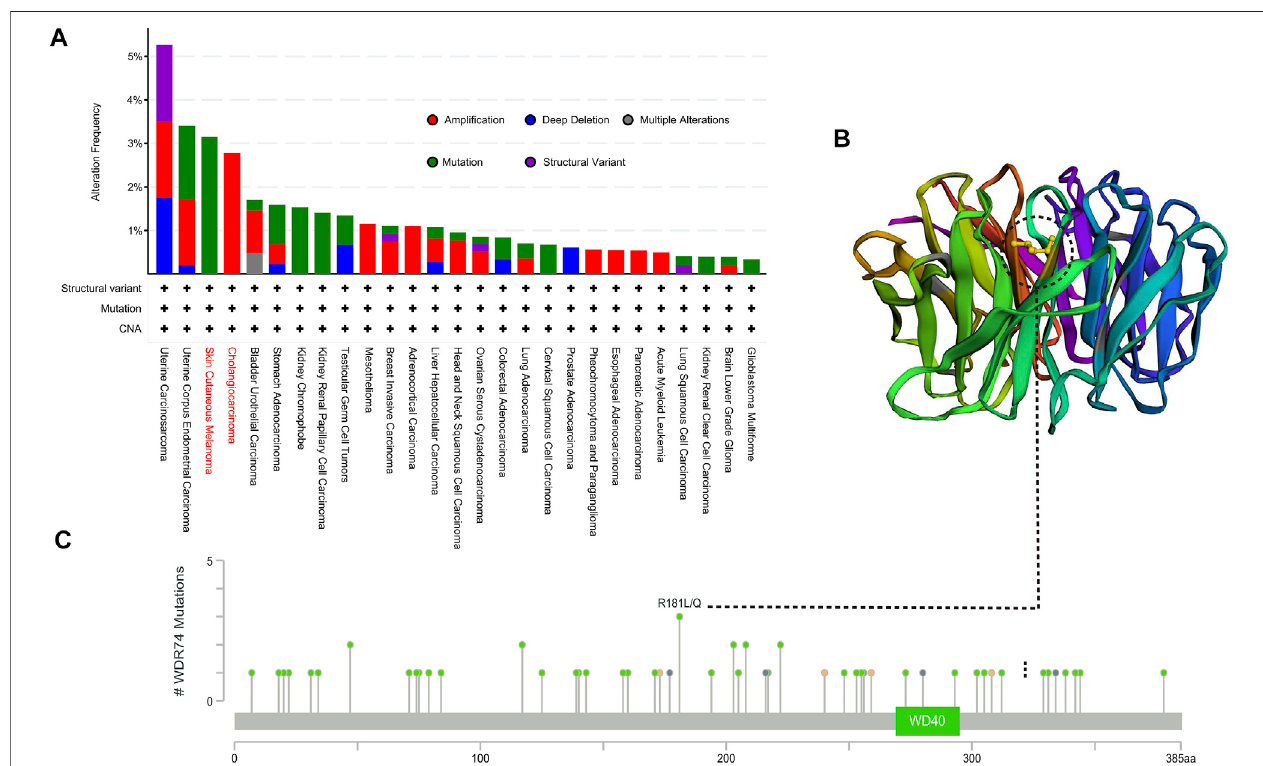
FIGURE 3 | Mutation features of WDR74 in multiple tumors based on TCGA were analyzed by the cBioPortal tool. The alteration frequency of mutation types (A) and mutation sites located on the coding region (C) are shown. The mutation site with the highest alteration frequency (R181L/Q) was highlighted in the 3D structure of WDR74 (B)